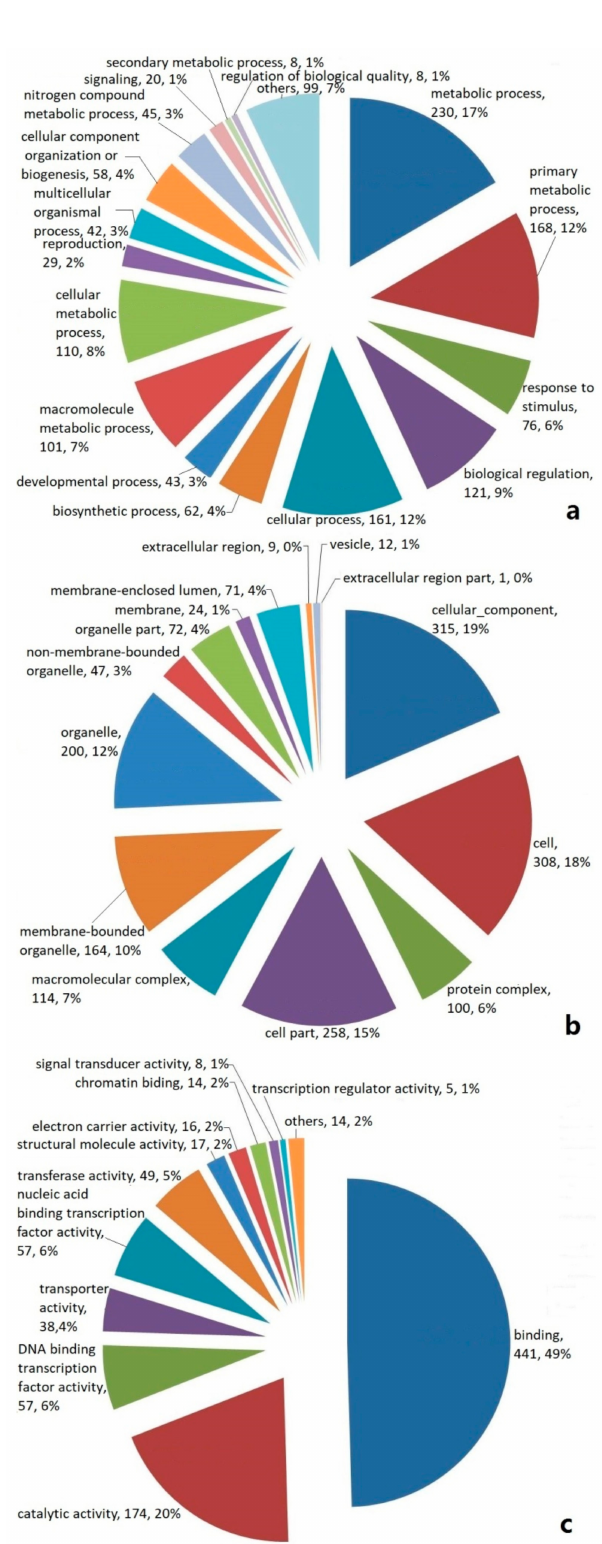
Figure 2. Distribution of EST-SSR-encoded unigenes in P. cablin classified according to their biological function, namely, ( a ) biological process, ( b ) cellular component, and ( c ) molecular